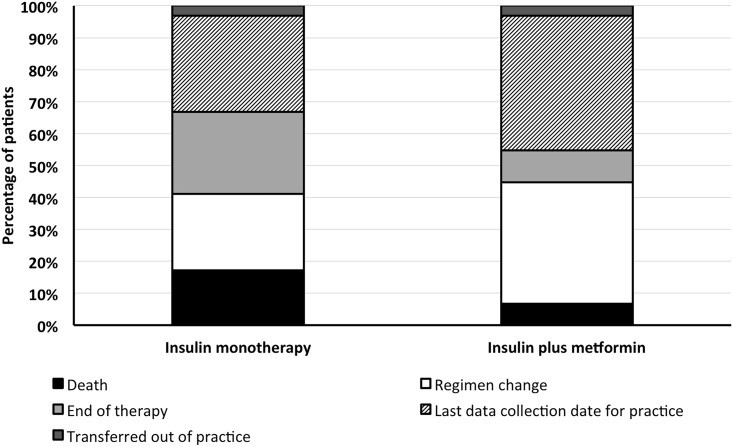
Reasons for censorship.Censorship crieria were applied in the order shown in the key below'.